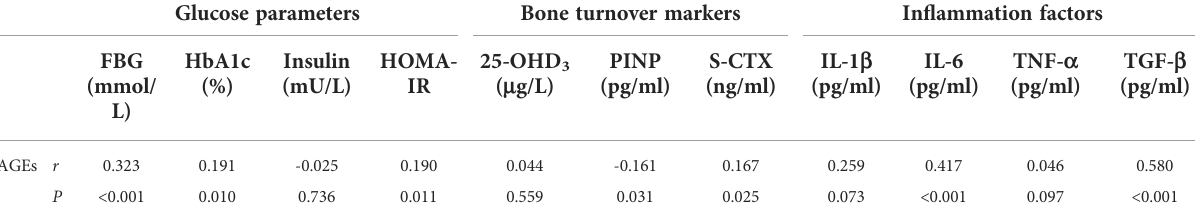
TABLE 3 Correlations of glycemic parameters, bone turnover markers, and in fl ammatory factors with AGEs among postmenopausal type 2 diabetic patients. Glucose parameters